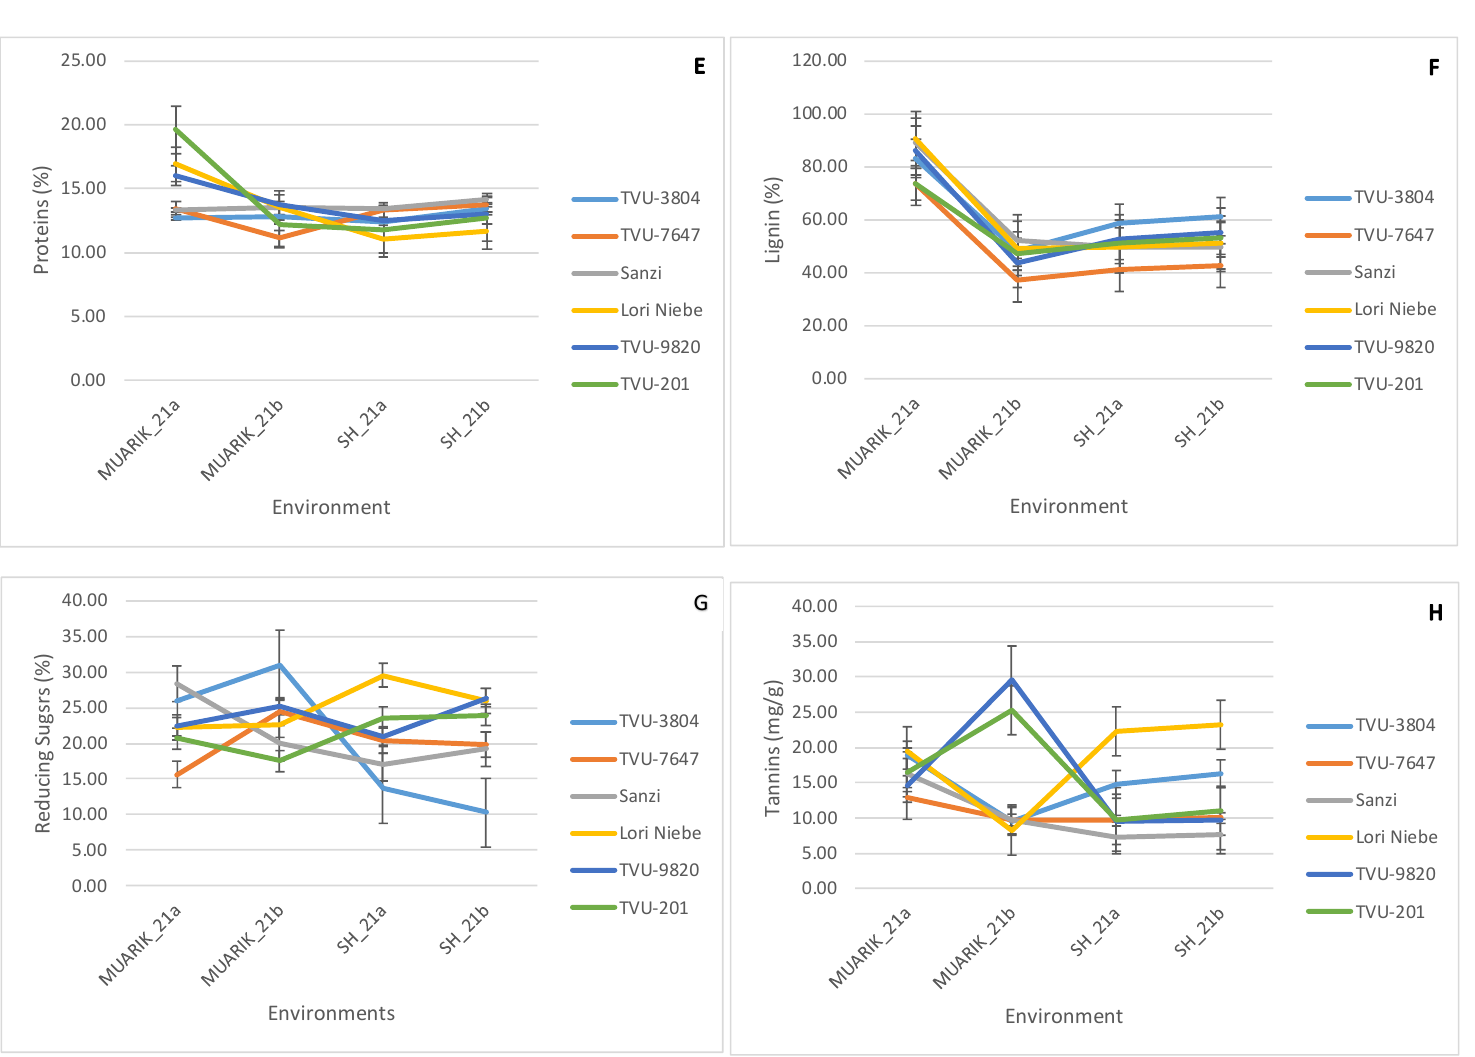
Figure 3. Performance of six cowpea genotypes for thrips damage ( A ), flavonoids ( B ), antioxidants ( C ), phenolics ( D ), proteins ( E ), lignin ( F ), reducing sugars ( G ) and tannins ( H ) evaluated in the field (MUARIK) and screen house (SH) experiments for short and long rain